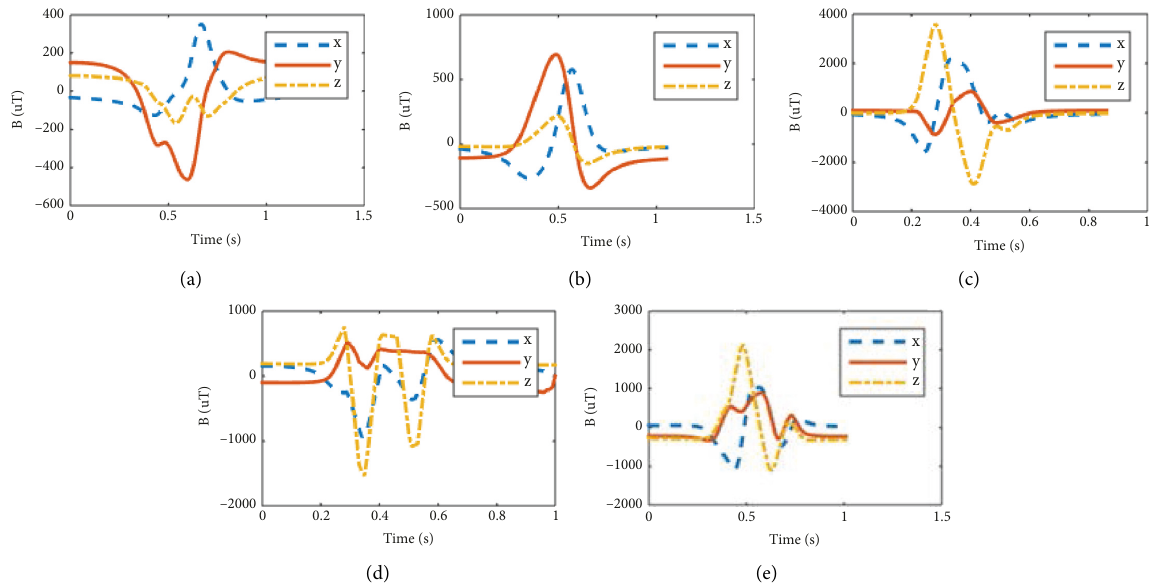
Figure 8: Waveform in different scenarios. (a) Scenario 1. (b) Scenario 2. (c) Scenario 3. (d) Scenario 4. (e) Scenario